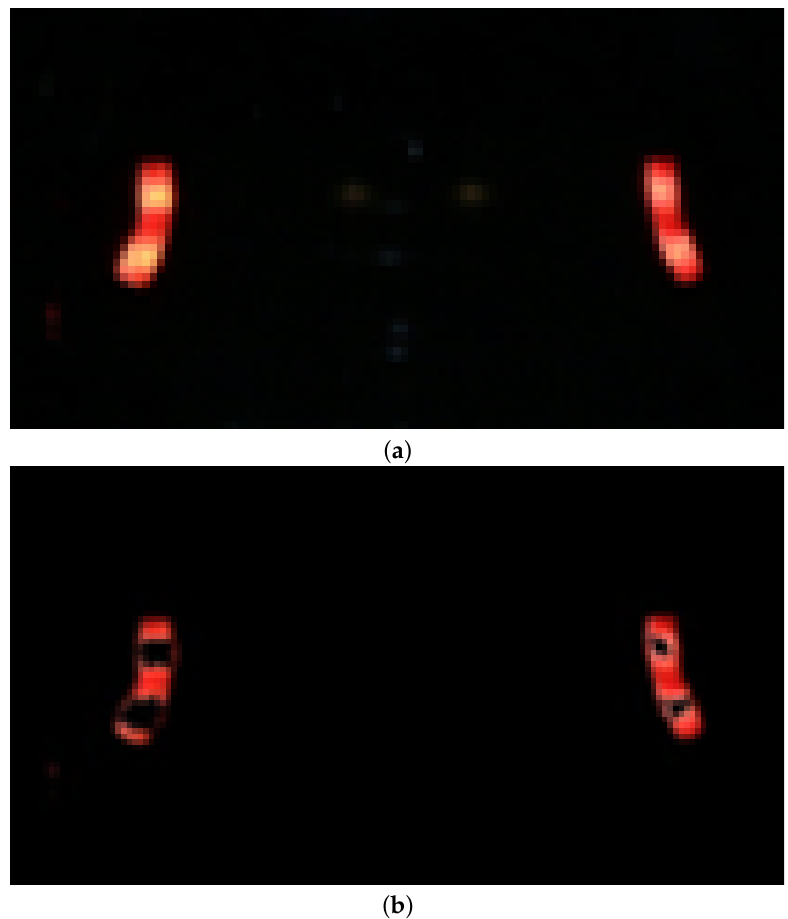
Figure 5. HSV color thresholding: ( a ) input image; ( b ) interesting